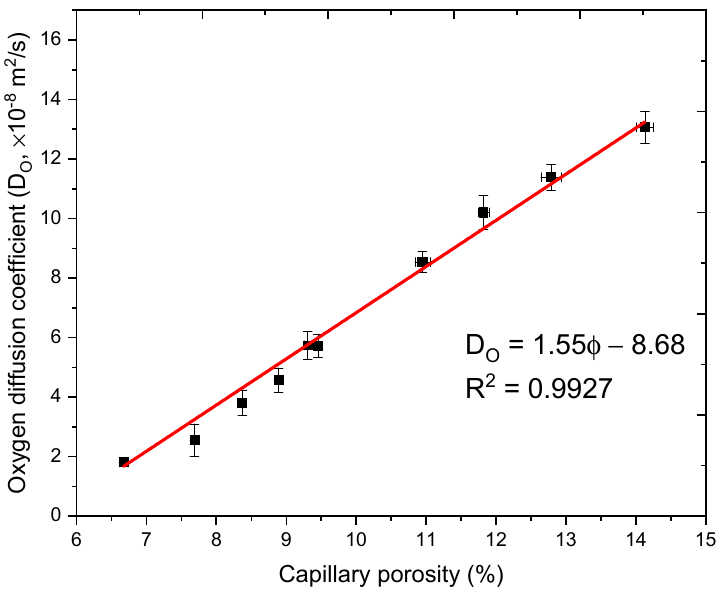
Figure 8. Oxygen diffusion coefficient results in terms of capillary porosity values.